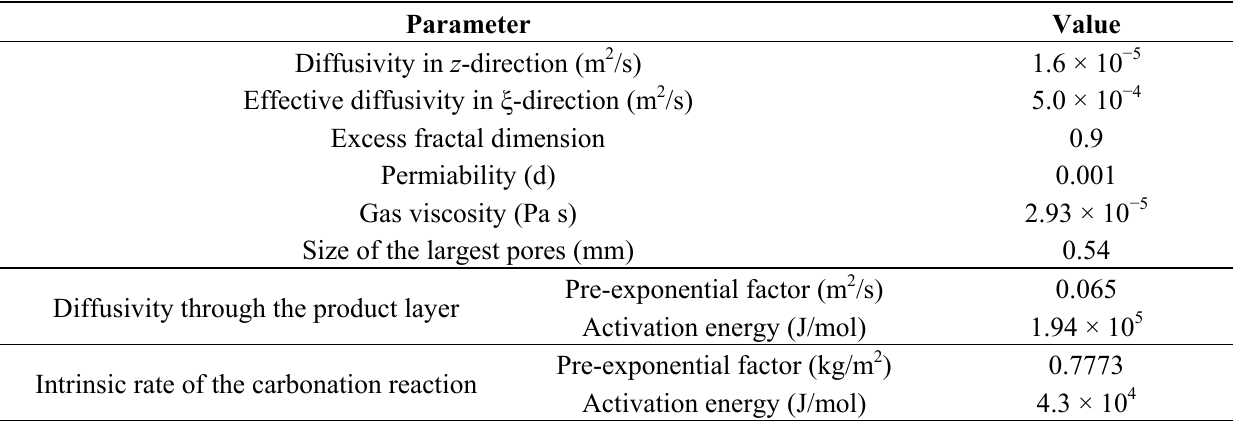
Table 2. Adjustable parameters of the